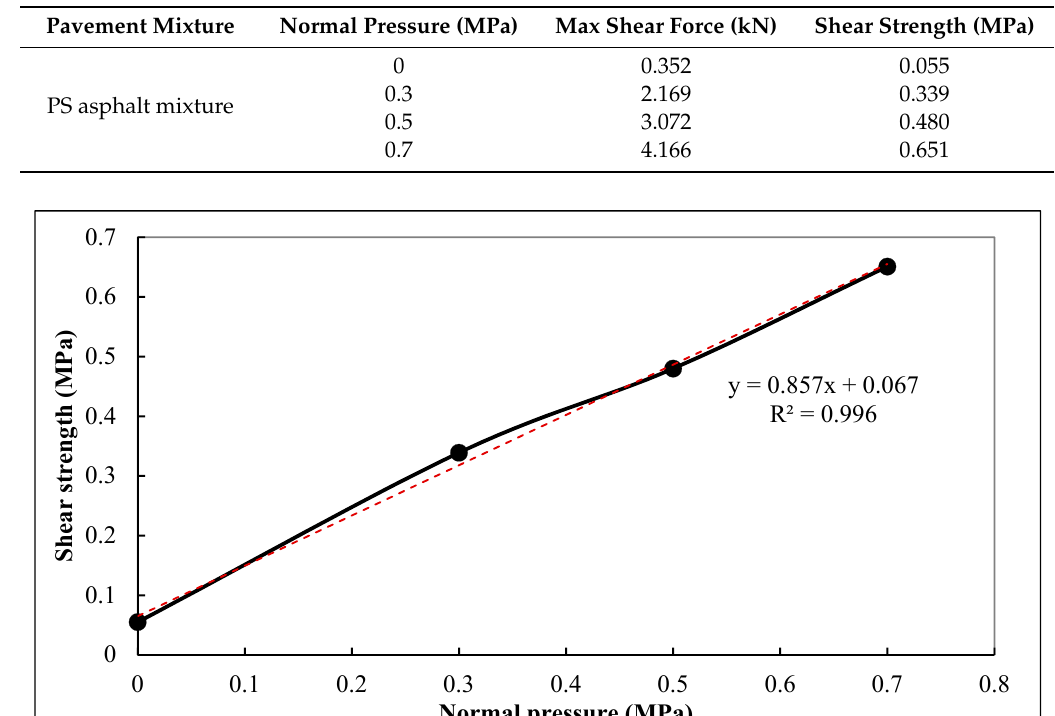
Figure 9. Relationship between normal pressure and interlaminar shear strength.